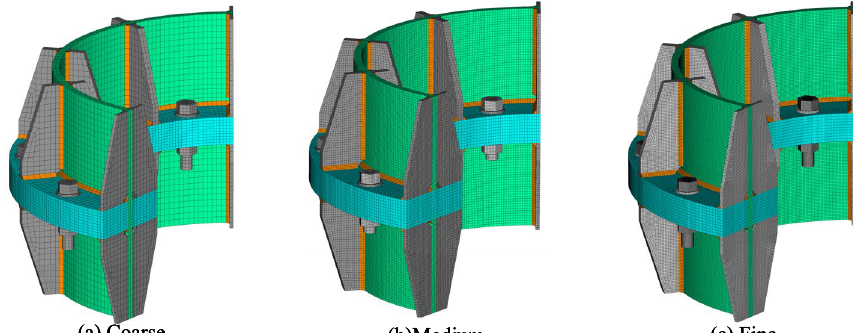
Figure 7. Three types of mesh.